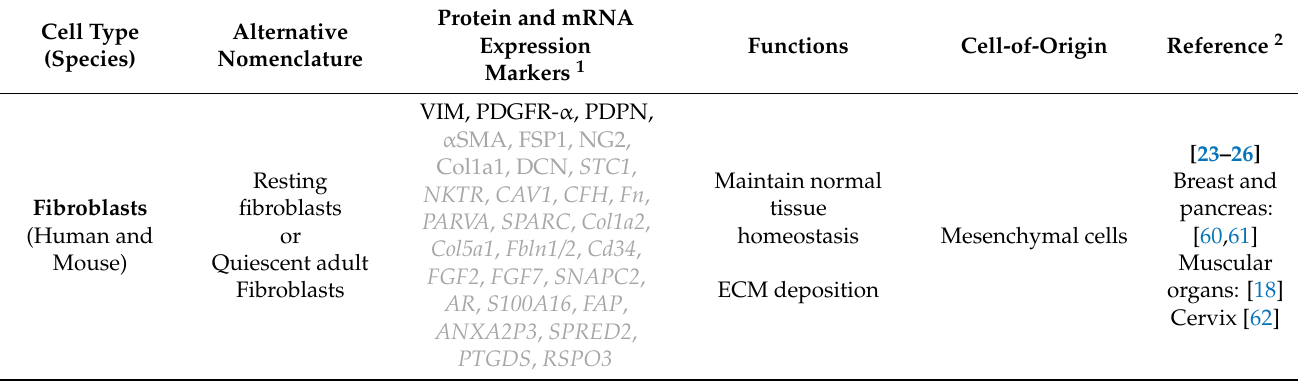
Table 1. Overview of normal adult prostate tissue fibroblasts markers, function and